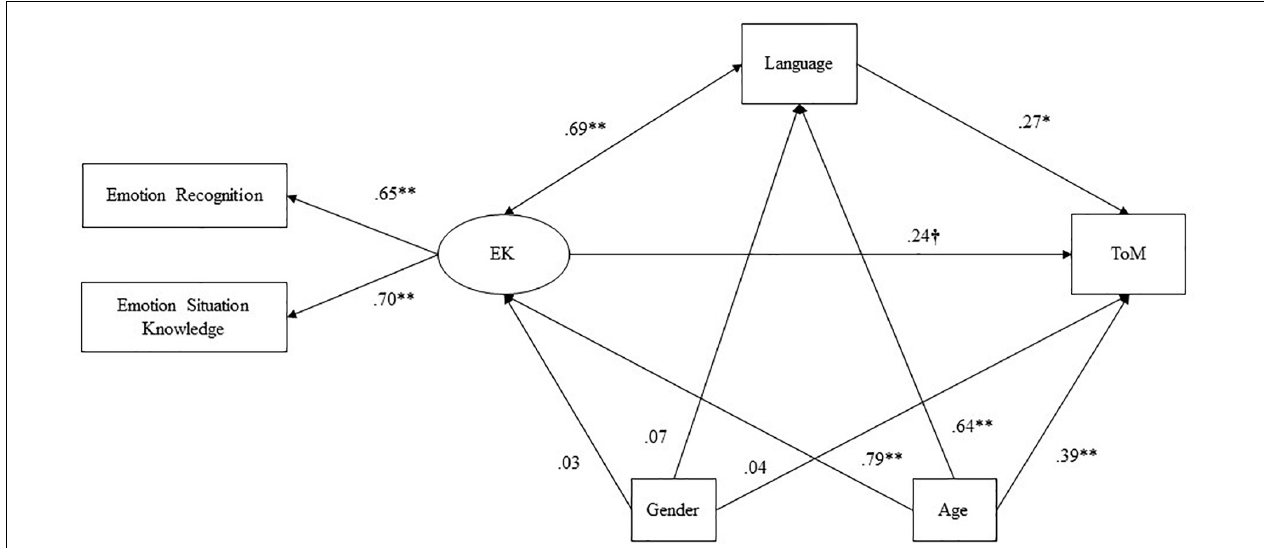
FIGURE 2 | Results of the structural equation analysis. Standardized direct effects were reported. † p = 0.069, ∗ p < 0.05, and ∗∗ p <